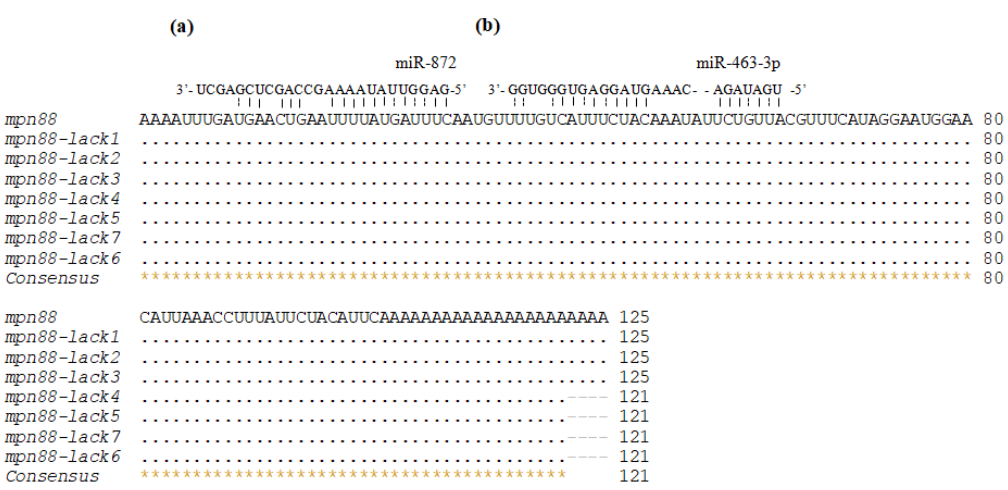
Figure 5. The predicted interactions of miR-872 and miR-463-3p with the 3 ’ untranslated regions (UTRs) of MPN88 family genes. The target sites of miR-872 ( a ) and miR-463-3p ( b ) in the 3 ’ UTRs of eight MPN88 family genes identified by RNA22 and RNAhybrid, respectively.